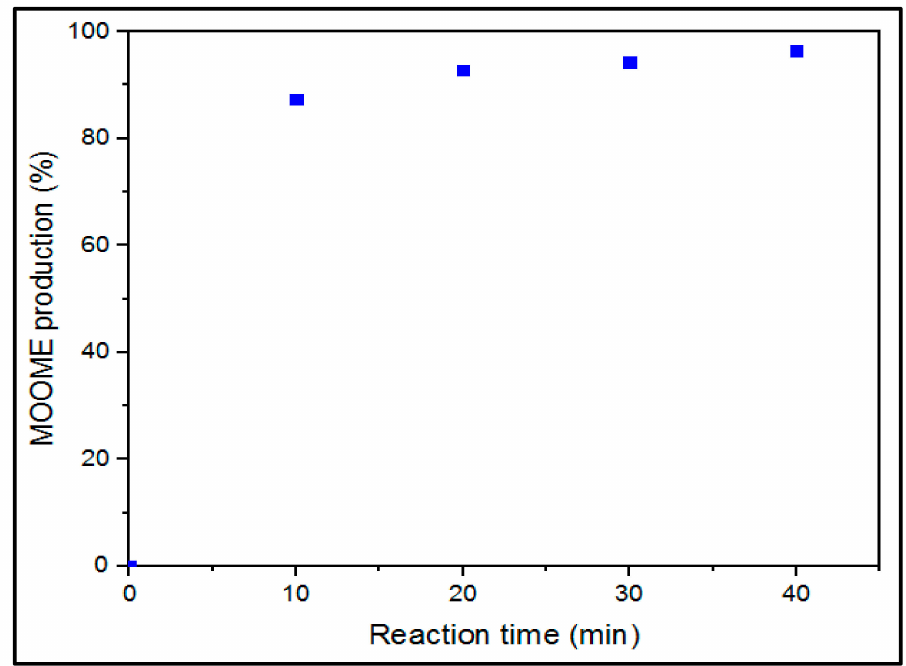
Figure 10. Production plot of MOOME yield against